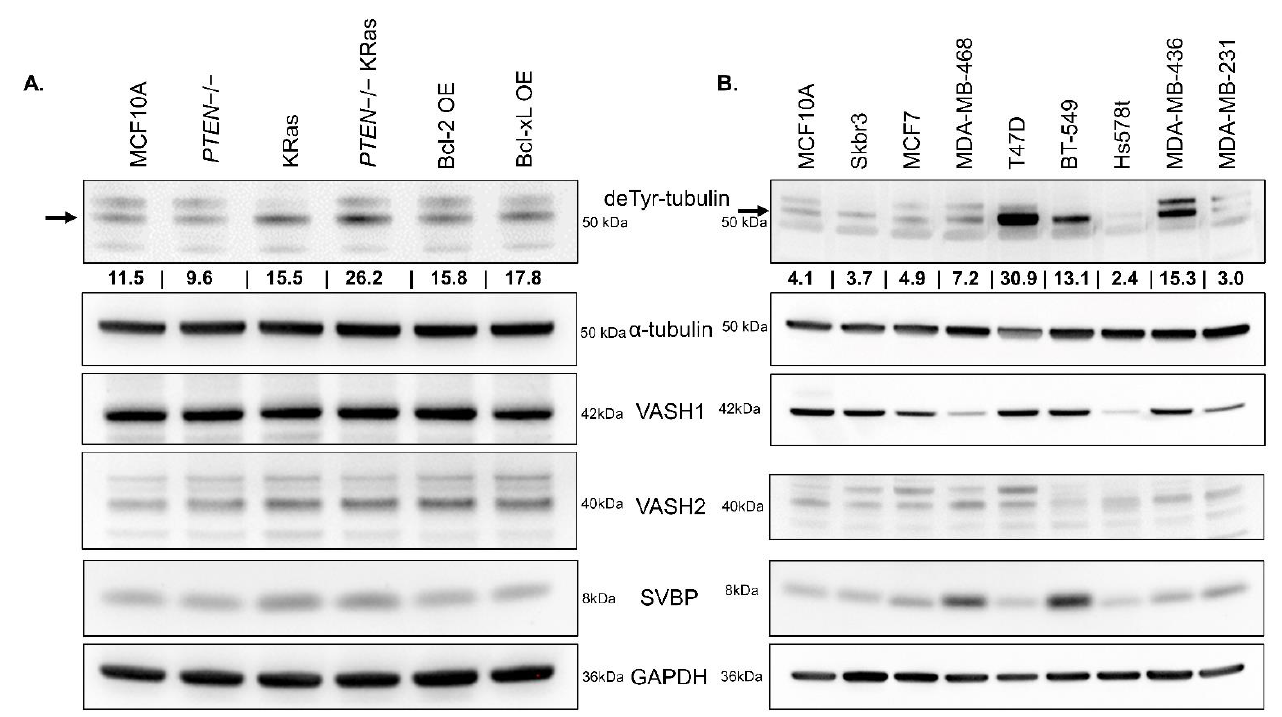
Figure 5. Components of the TCP across cell lines do not correlate with the level of deTyr-Tub. ( A ) Protein was isolated from MCF10As and the MCF10A variants using RIPA lysis buffer. DeTyr-Tub (1:10000), total alpha-tubulin (1:1000), and the components of the TCP ( VASH1 (1:1000), VASH2 (1:1000), and SVBP (1:1000)) were probed. An increase in basal level of deTyr-Tub can be seen in the MCF10A cell lines with oncogenic KRas , that is not present in the MCF10A parental or anti-apoptotic MCF10A cell lines. The level of VASH1 and VASH2 appears to be consistent across all lines, with a small increase in SVBP in the KRas containing lines. ( B ) To better understand the presence of deTyr-Tub and TCP components in breast cancer, a number of commonly used breast cancer cell lines were lysed using RIPA buffer and subjected to immunoblotting. These breast cancer cell lines contain various basal amounts of deTyr-Tub, VASH1 , VASH2 , and SVBP with no clear connection between components of the TCP and level of deTyr-Tub. The values under deTyr-Tub indicate the raw intensity/1000 for the band above without any normalization.